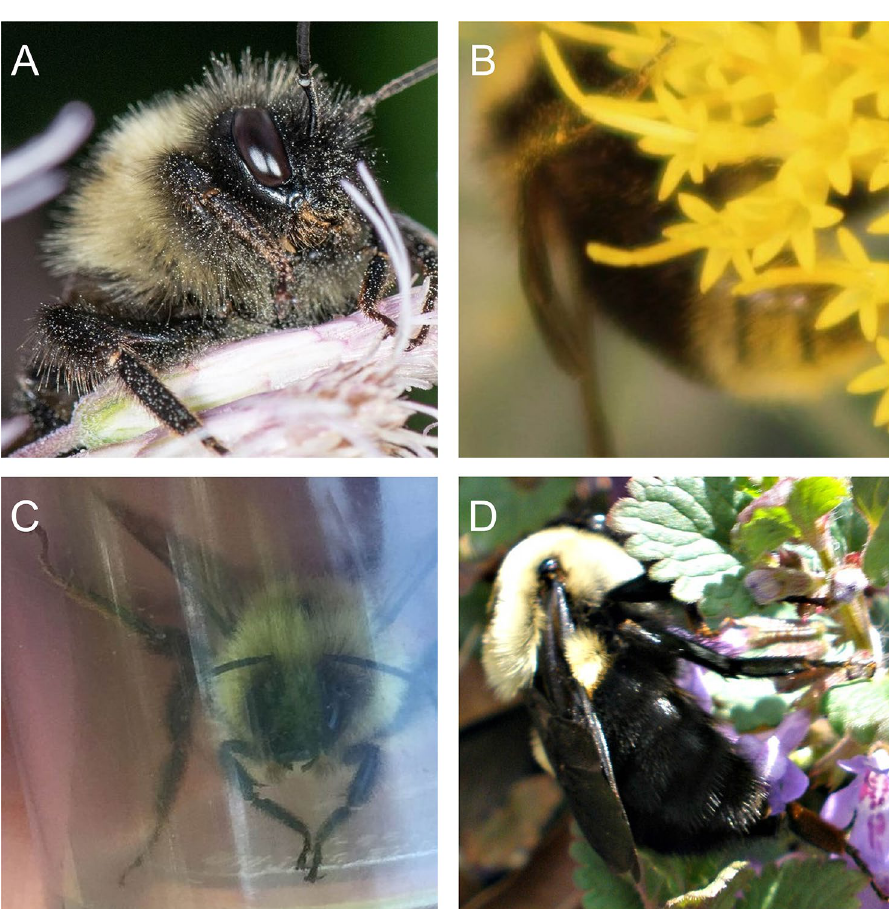
Figure 4. Examples of misclassified images. ( A ) B . affinis misclassified as B . citrinus . ( B ) B. occidentalis misclassified as B. terricola . ( C ) B. bimaculatus misclassified as B. impatiens . ( D ) B. griseocollis misclassified as B. impatiens . Photo credits: ( A ) Heather Holm, ( B ) Bernard Yurke, ( C ) Sarah Litterick, ( D ) Ansel